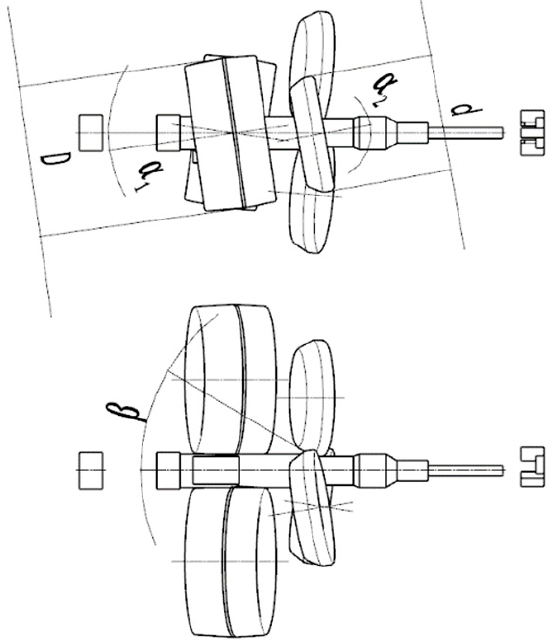
Figure 28. Design of the process for producing hollow axle [37] (Reprinted from ref. [37]). Caoqi et al. [37] creatively put forward tandem flexible skew rolling on the basis of tandem skew rolling, clarified the value range of the tandem flexible skew rolling deflection angle of two sets of rolls and the principles to be followed, simulated the process of rolling the hollow axle with finite-element software, and analyzed the change law of force parameters in the rolling process, as well as the strain and temperature distribution of the rolled axle blank (Figures 29–31), The simulation results verify the feasibility of rolling the hollow axle with this technology, and lay a theoretical foundation for the short process of forming hollow axle